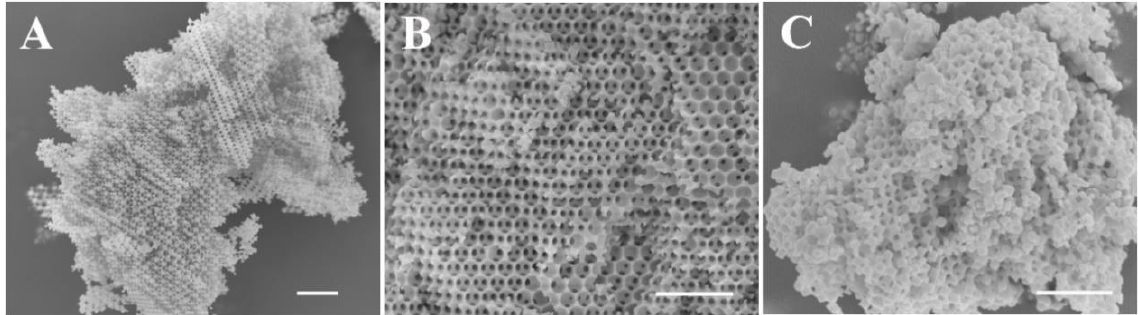
Figure 2. SEM images of 2/AS-IO-CsPbBr 3 ( A and B ) and 2/RS-IO-CsPbBr 3 ( C ). Scale bars: 1 μm.